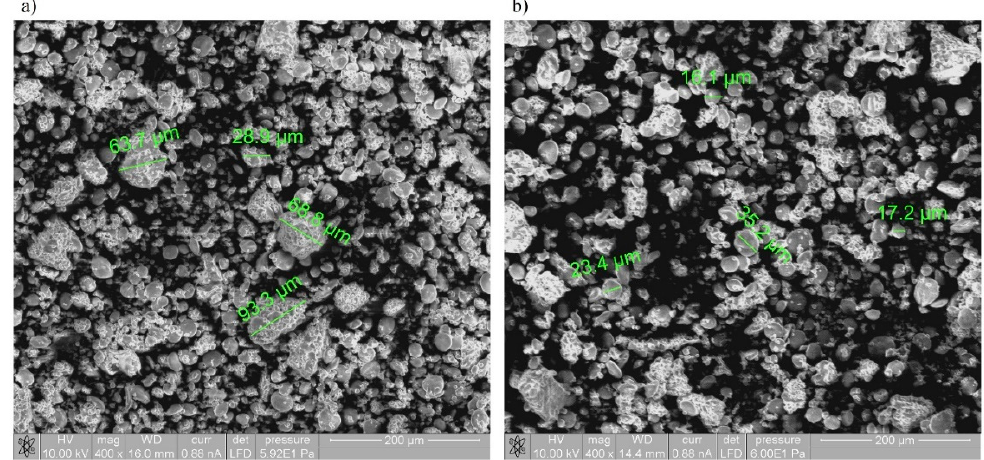
Figure 3. Scanning electron micrographs (SEM) of ( a ) untreated spelt flour and ( b ) scCO 2 -treated spelt flour. Magnification: ×400.